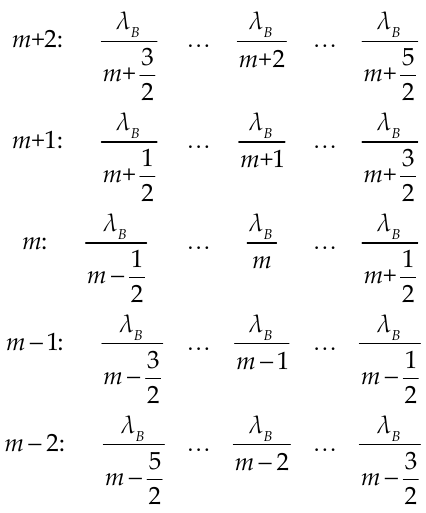
Figure 3. The wavelength distribution at each order.